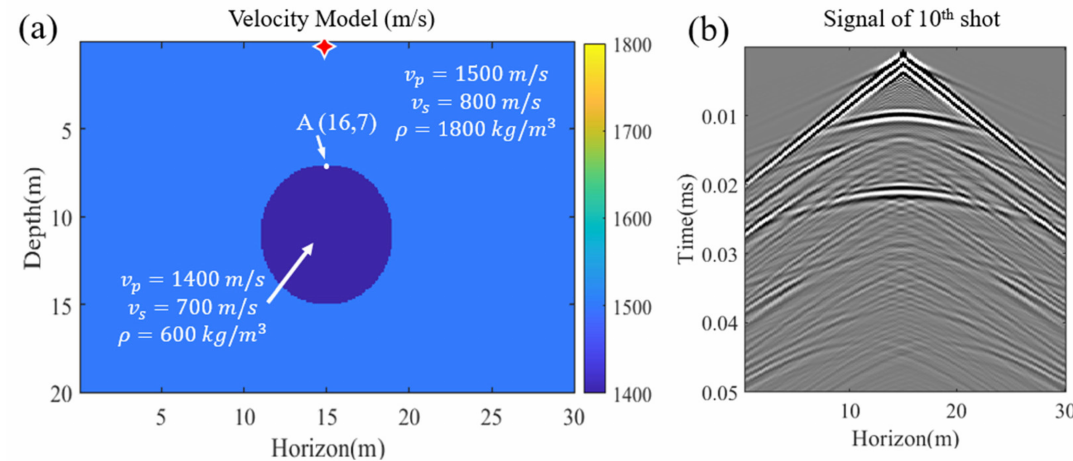
Figure 2. ( a ) Circular cave model. ( b ) Signal of the 10th shot with 20 stacked traces.